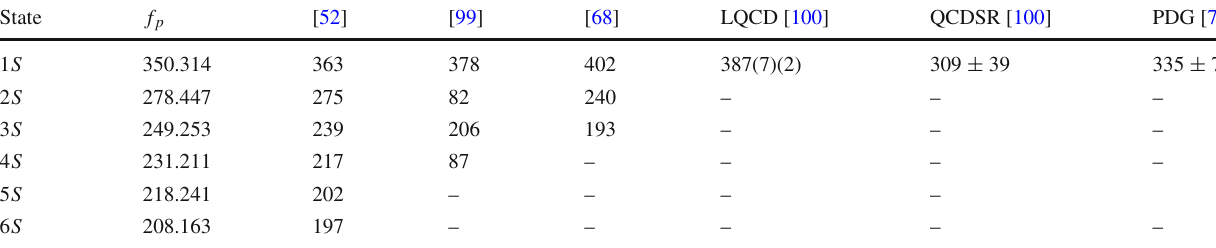
Table 8 Pseudoscalar decay constant of charmonia (in MeV)